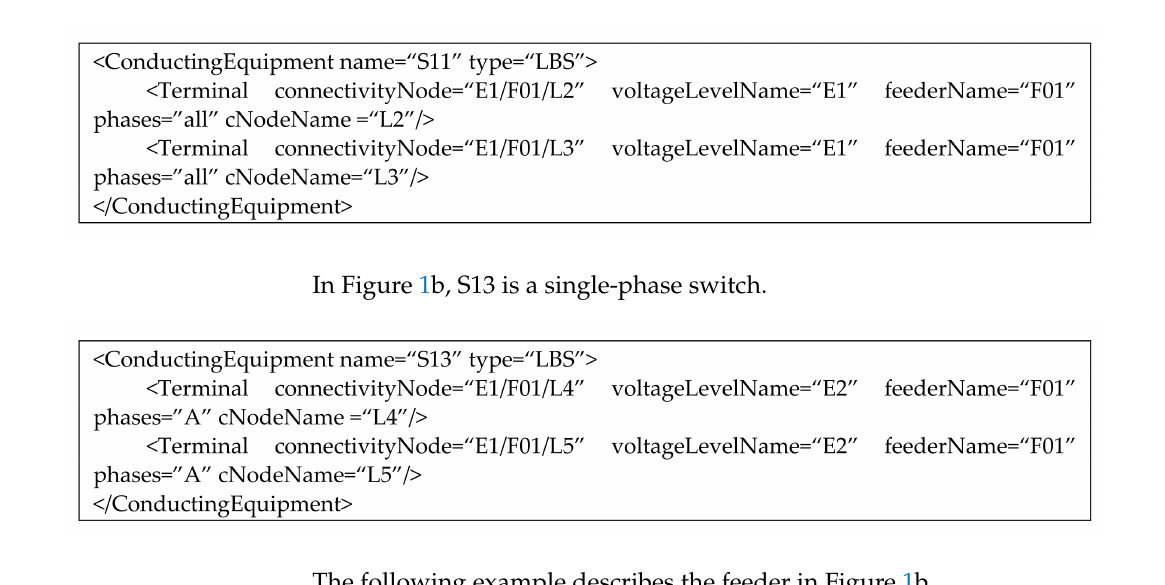
The following example describes the feeder in Figure